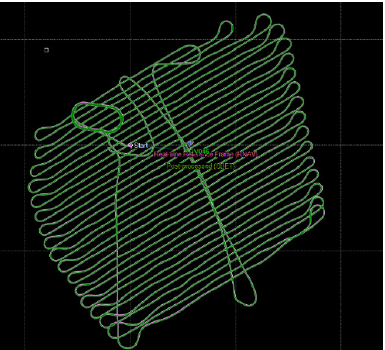
Figure 3: Representation of real-time reference frame (purple) and post-processed smoothed best estimated trajectory